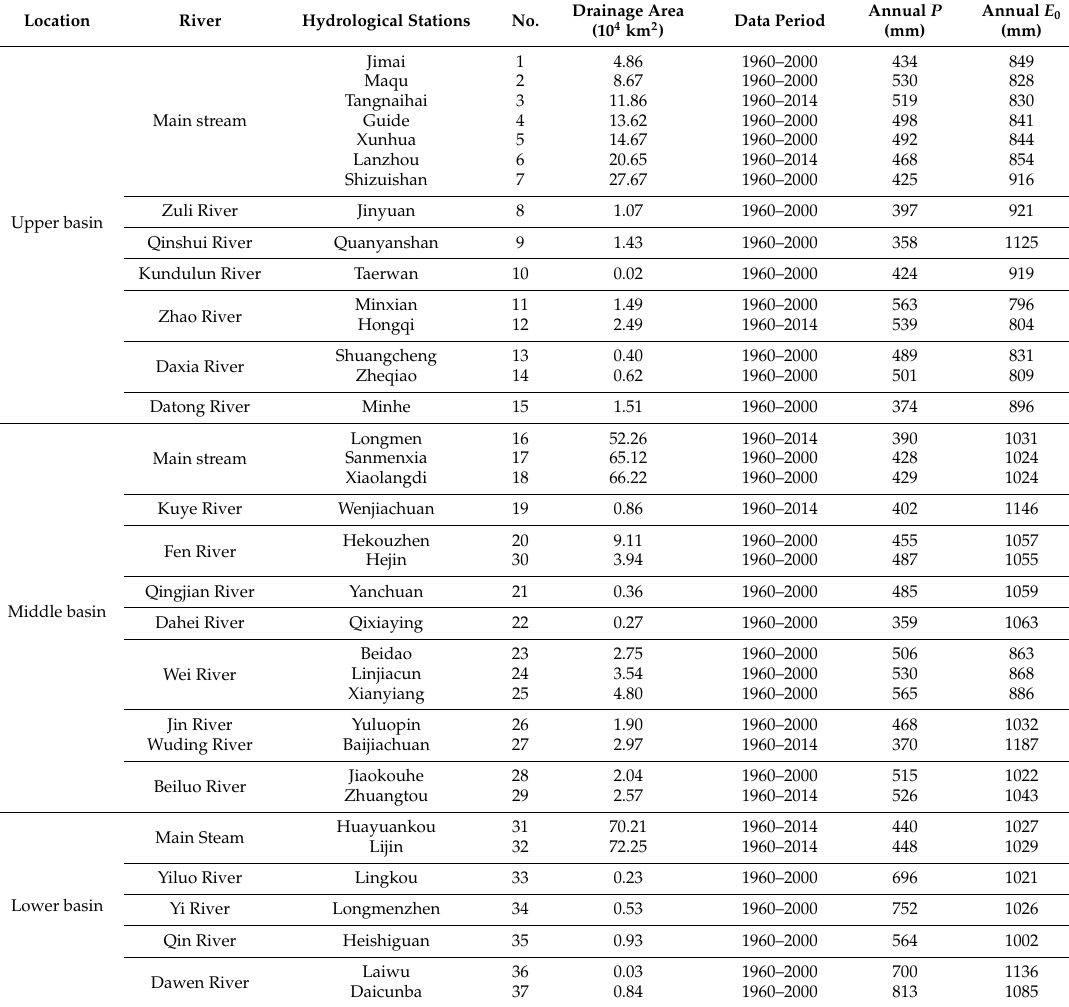
Table 1. Basic characteristics of 37 hydrological stations throughout the Yellow